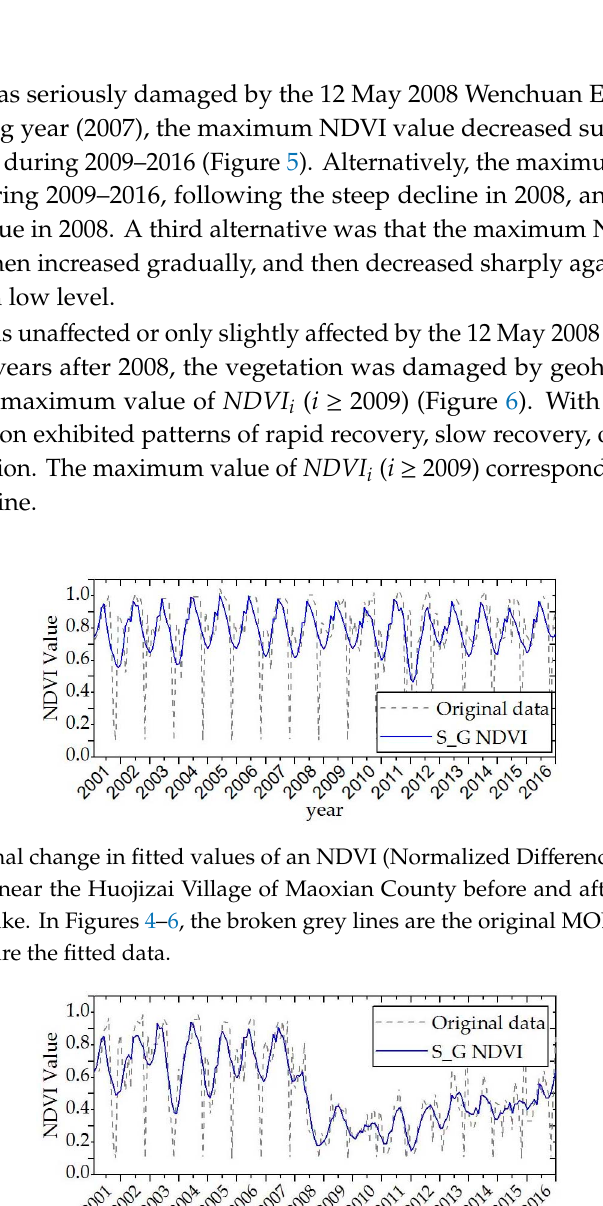
Figure 5. The maximum value of a fitted NDVI pixel decreased sharply in 2008 on the Daguangbao landslide in Anxian County, as a result of the 12 May Wenchuan Earthquake, and dropped again in 2009 and 2010, then increased gradually in the following years.